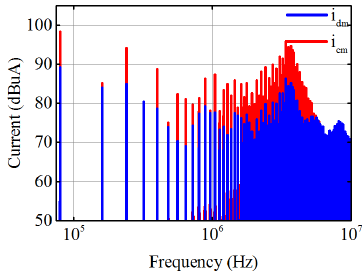
Figure 23. Comparison between calculated spectra of i dm and i cm .